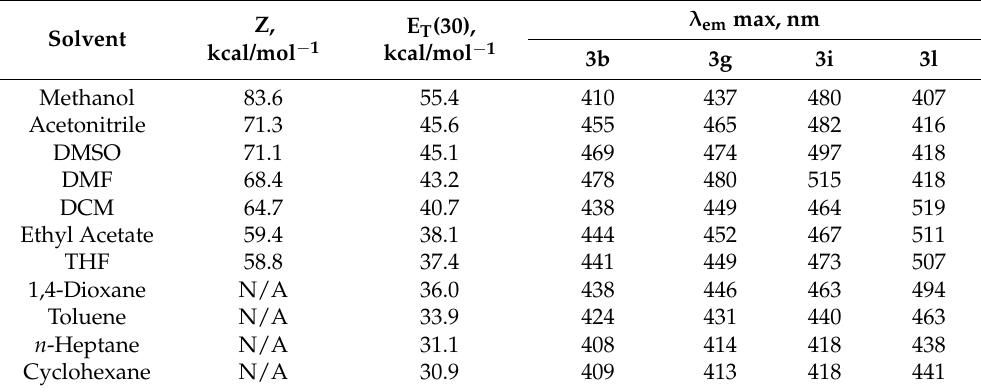
Table 3. Emission maxima for compounds 3b , g , i , l in different solvents and Z and ET(30) parameters for the solvents .